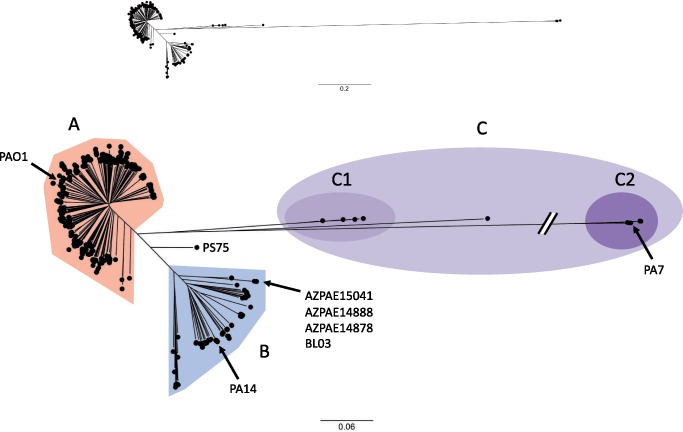
—Population structure of Pseudomonas aeruginosa isolates. The upper panel shows a maximum likelihood phylogenetic tree generated from core genome SNP loci in 739 P. aeruginosa isolates. The lower panel shows an expanded version of the same phylogenetic tree with a truncated outlier branch. Major branches are indicated by labels and highlighting: Group A (red), Group B (blue), and Group C (purple). Group C isolates are further subdivided into Group C1 (light purple) and Group C2 (dark purple). Several isolates mentioned in the text are indicated. The scale bars represent genetic distances.